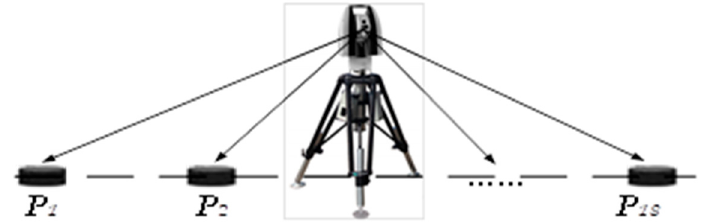
Figure 4. Schematic diagram of horizontal angle calibration.